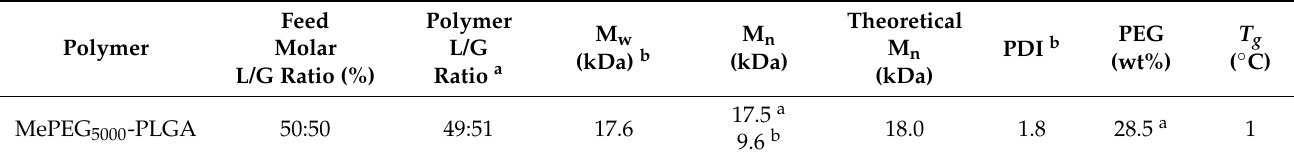
Table 1. Characteristics of the synthesized PEG-PLGA block